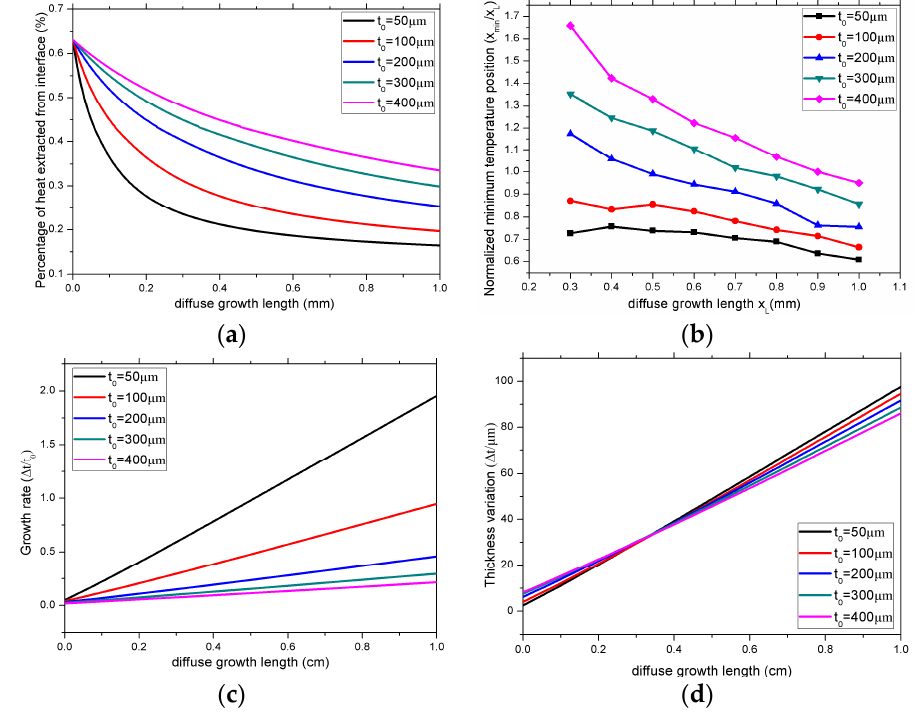
Figure 5. ( a ) Relationship between percentage of heat extracted from surface and diffuse growth length with different initial thickness ( q 0 = 120 W/cm 2 , V exp = 2 mm/s). ( b ) Relationship between normalized minimum temperature position ( x min / x L ) and diffuse growth length with different initial thicknesses. ( c ) Under the same working condition with ( a ), the relationship between diffuse growth rate ∆ t / t 0 and growth length with different initial thickness. ( d ) Under the same working condition with ( a ), relationship between diffuse growth thickness and growth length with different initial thickness.